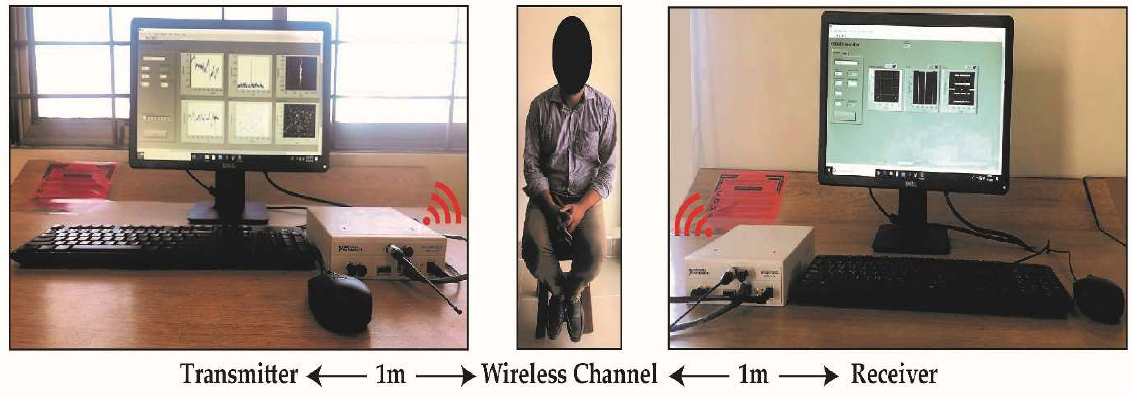
Figure 6. Non-contact breathing sensing experimental setup.